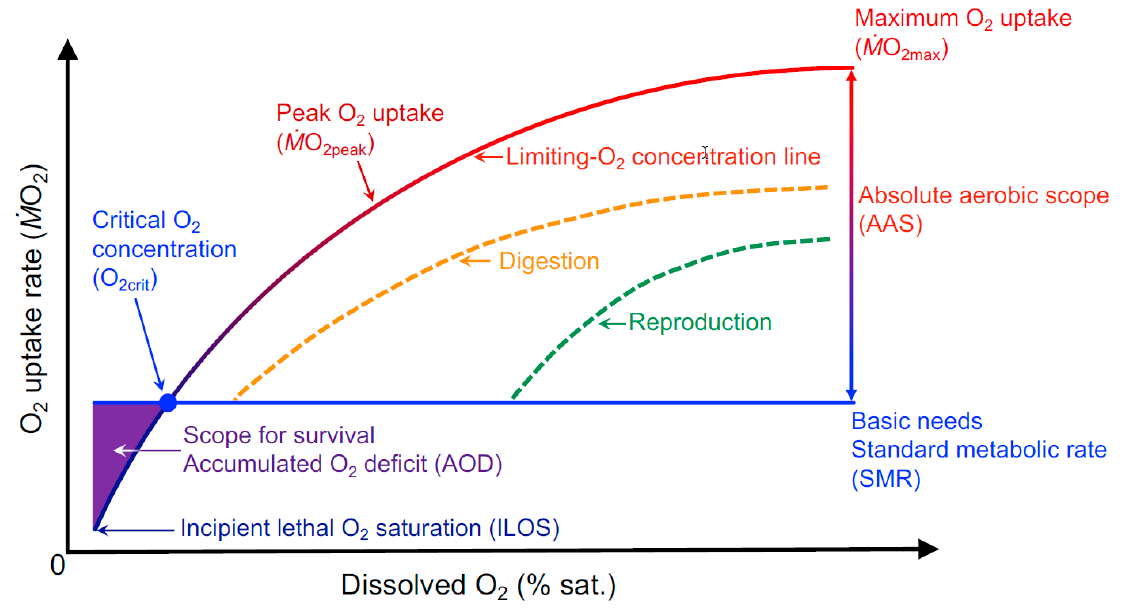
Figure 2. A conceptual representation of the oxygen (O 2 ) needs and capacities for supply in a fish as a function of the dissolved O 2 in the water (% sat.). The various curves and their placement acknowledge and unify several concepts already advanced in the literature. The upper bounding limiting-O 2 concentration (LOC) line for peak O 2 uptake ( ˙M O 2 ) (which is maximum O 2 uptake, ˙M O 2max , under normoxic conditions) and those for digestion and reproduction are based on the conceptual framework for hypoxic performance curves [11,25,36], and the experimental LOC lines generated for groups of fish [52,53]. An LOC performance curve, therefore, bounds and sets the capacity for the potential use of O 2 for all other activities, as similarly suggested beyond the pejus temperature for warming [54], potentially including a buffer in O 2 availability before an activity is constrained [1]. Exactly how O 2 is apportioned amongst the various activities and what governs the apportioning are unknown, and so the shape and positioning of the broken lines are unknown. We define O 2crit as a minimum amount of ambient O 2 concentration at which a fish can aerobically sustain its whole-organism minimum maintenance metabolic demands, i.e., its standard metabolic rate (SMR) [10,46]. Thus, below O 2crit , ˙M O 2 conforms in some manner with O 2 availability and ATP needs for survival until incipient lethal O 2 saturation (ILOS; where death is imminent) must be met through a combination of oxidative phosphorylation, substrate-level phosphorylation, and possible suppression of some aspects of maintenance metabolism. Hochachka [55] coined the term scope for survival as the difference between SMR and the lowest sustainable rate to which metabolism may be suppressed before reaching ILOS. As an index of the scope for survival, we calculate accumulated O 2 deficit (AOD) as the integral of the area bounded by SMR and the ˙M O 2 measured between O 2crit and